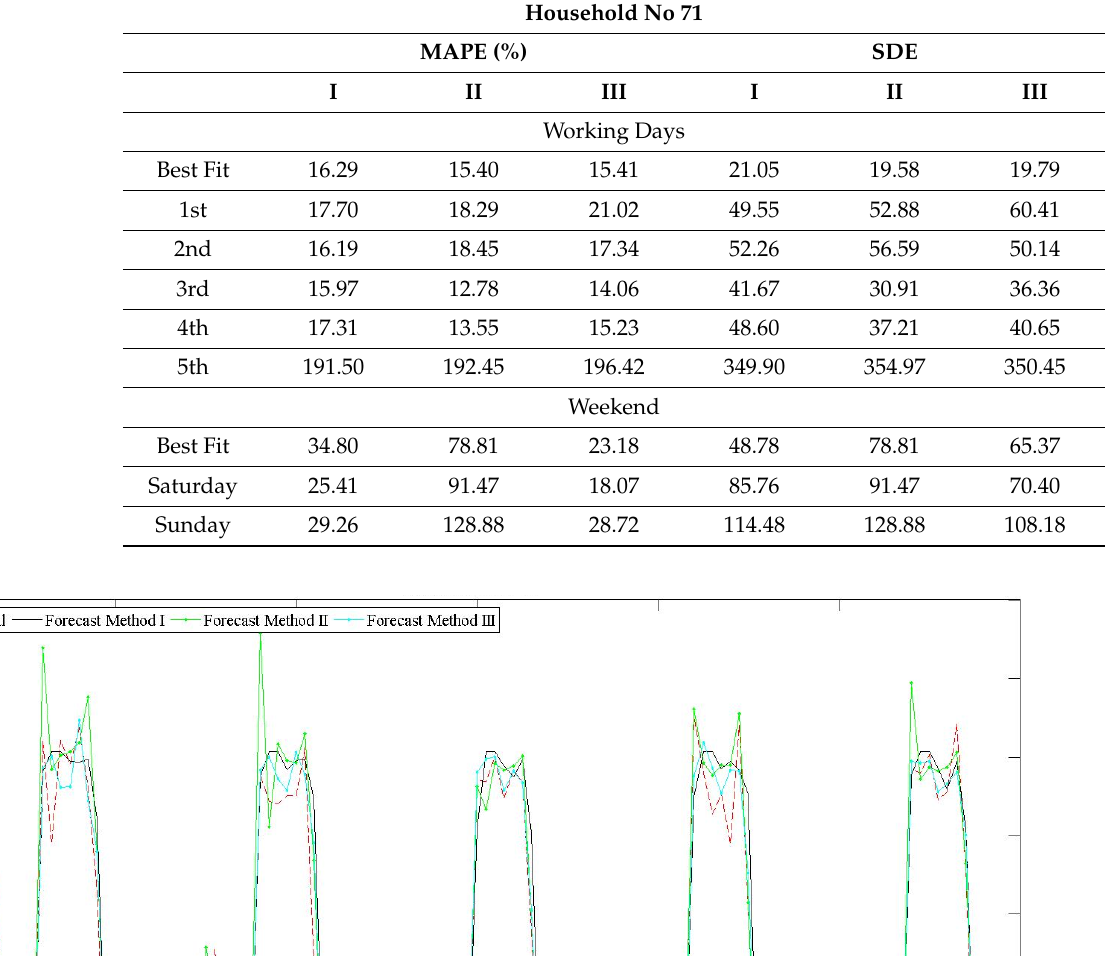
Table 4. Forecasting error values of the outputs.